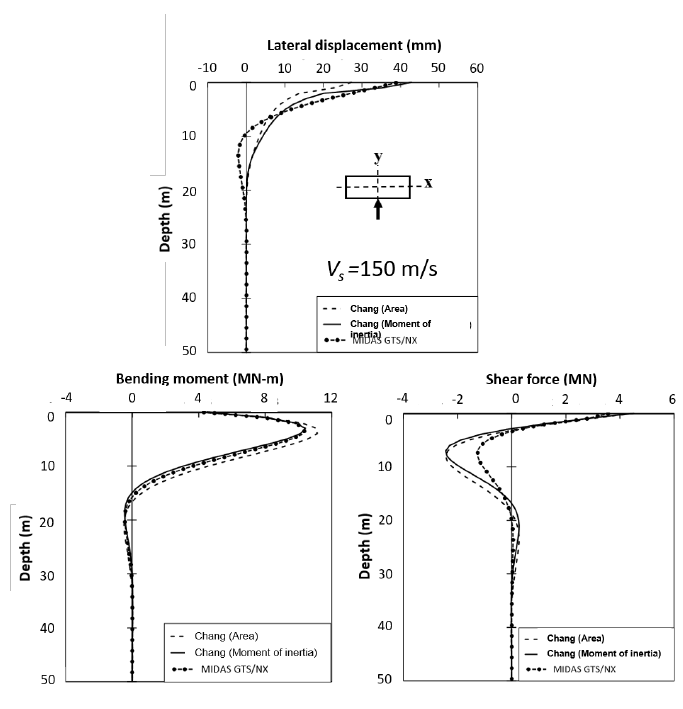
Fig. 19. Performance of barrette in clays with load applied in transverse direction